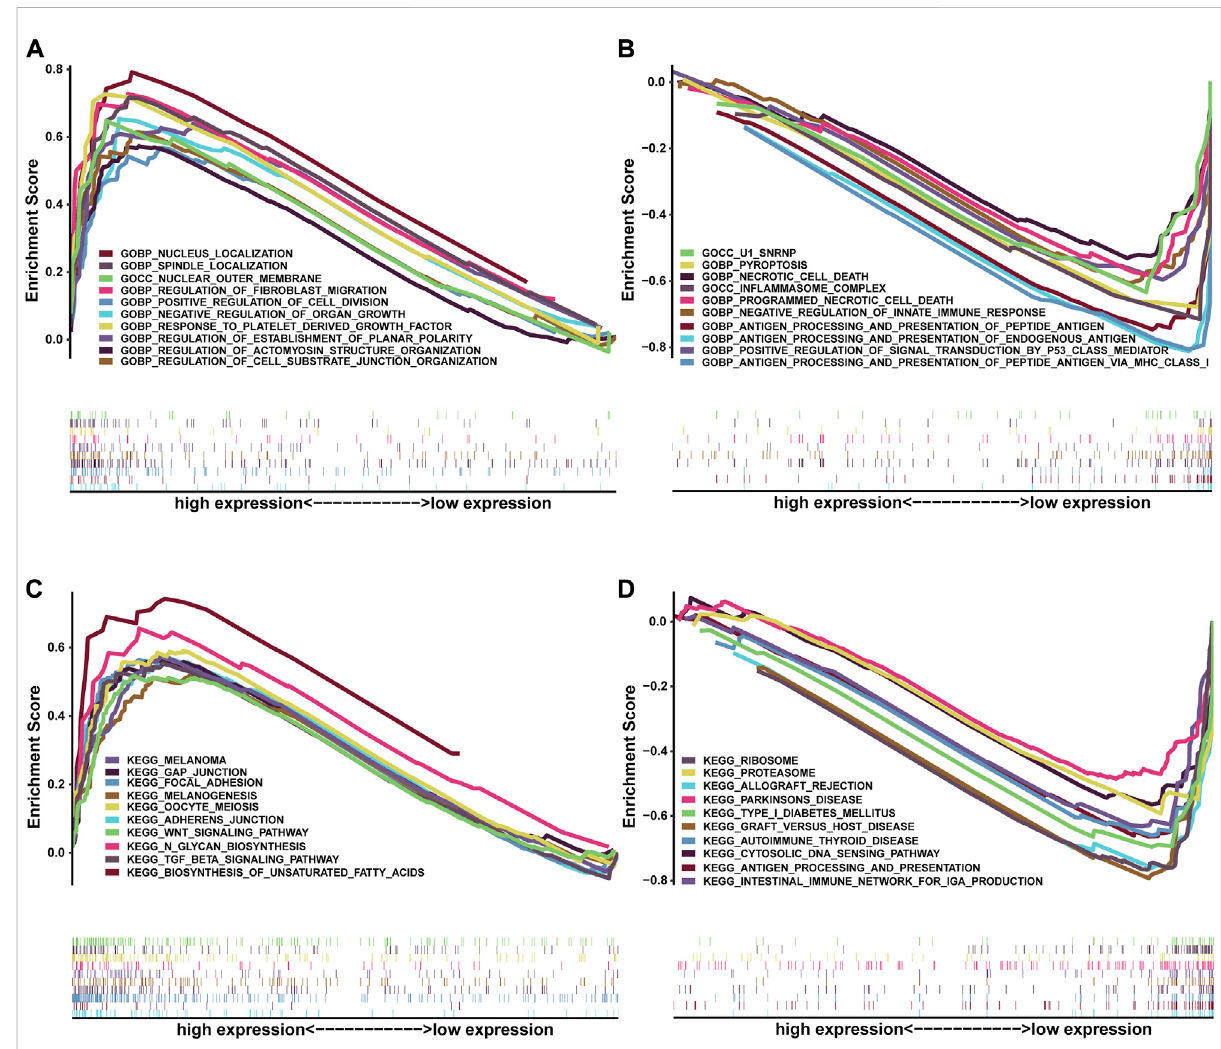
FIGURE 10 Correlation between NRG score and biological functions. GO-GSEA results of the high-risk group (A) and low-risk group (B) . KEGG-GSEA results of the high-risk group (C) and low-risk group (D)